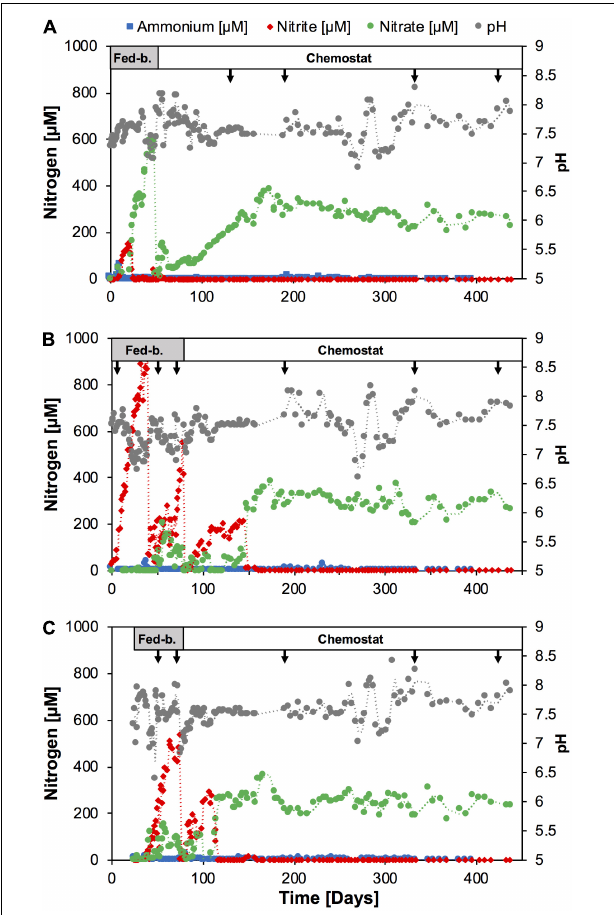
FIGURE 1 | Time course of nutrients and pH during continuous culture enrichments of nitrifiers directly from soil with SFCM media in reactor A (A) , and following batch culture pre-enrichment, in SFCM media in reactor B (B) and modified NGM media in reactor C (C) , respectively. Arrows indicate sampling points for amplicon sequencing analysis. Reactor operation modes are indicated on top. Fed-b., Fed-batch mode; Chemostat, chemostat mode. See Supplementary Figure 1 for nutrient and pH time course in subculture chemostat